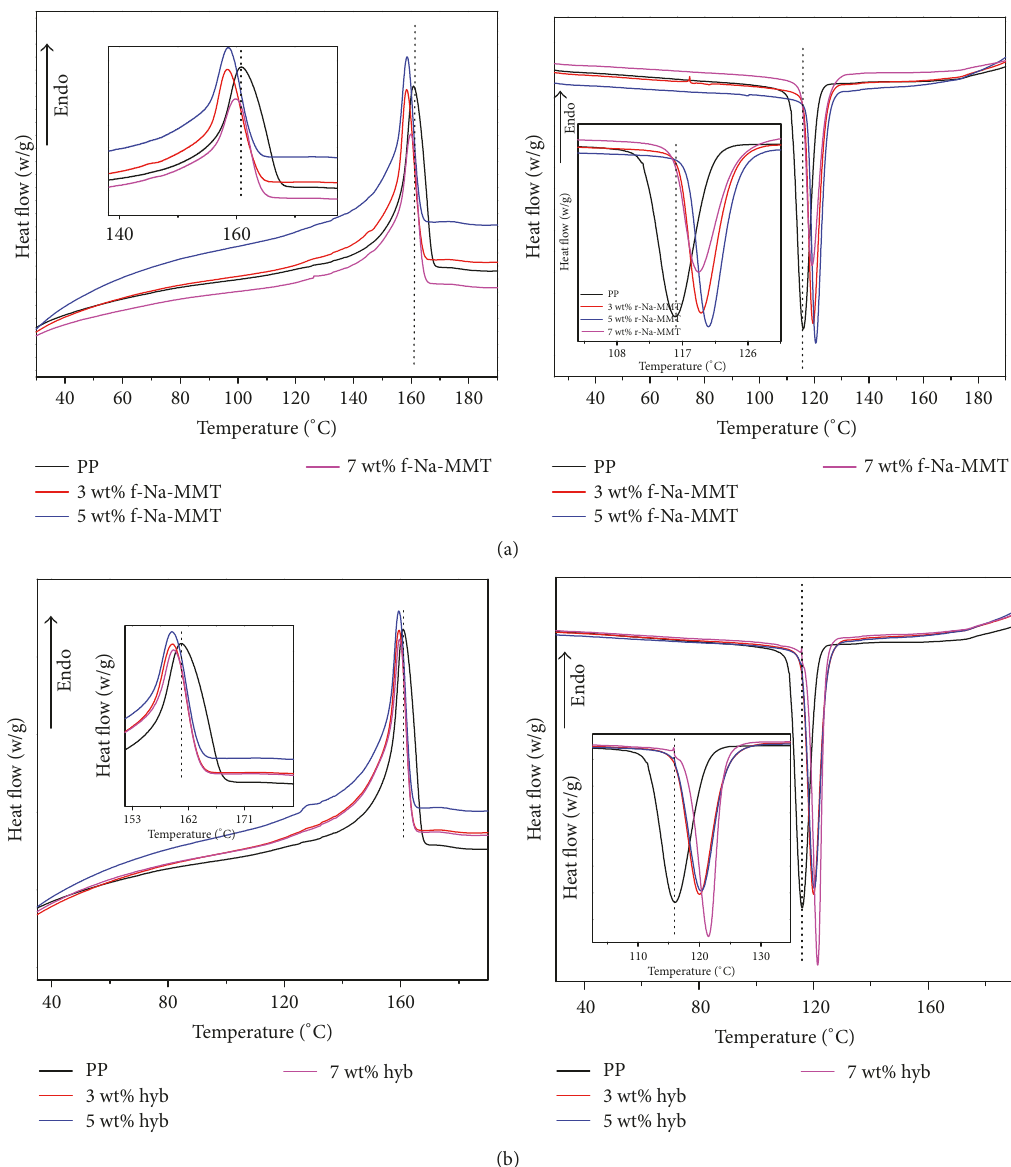
Figure 8: DSC thermographs of second heating and cooling runs of (a) f-Na-MMT/PP nanocomposite and (b) t-PAfs/f-Na-MMT/PP hybrid